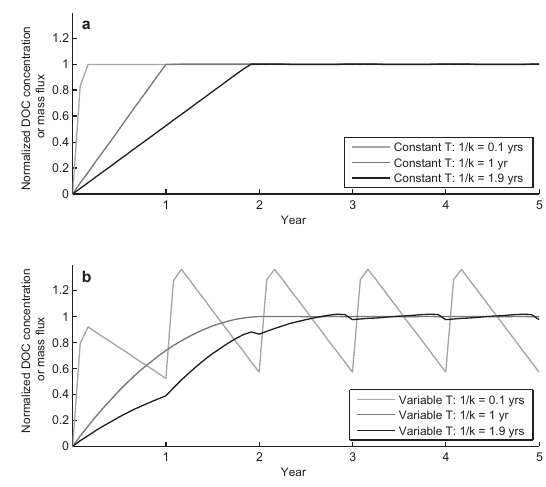
Fig. 4. DOC transport dynamics. (a) Results for a single stream tube with a single travel time, τ = 1yr. (b) Results for an ensemble of stream tubes with variable (uniformly distributed) τ , and average τ = 1yr. The results show how the release rate k (or characteristic release time 1 /k ) affects DOC concentration and mass flux from the soil–groundwater into the stream